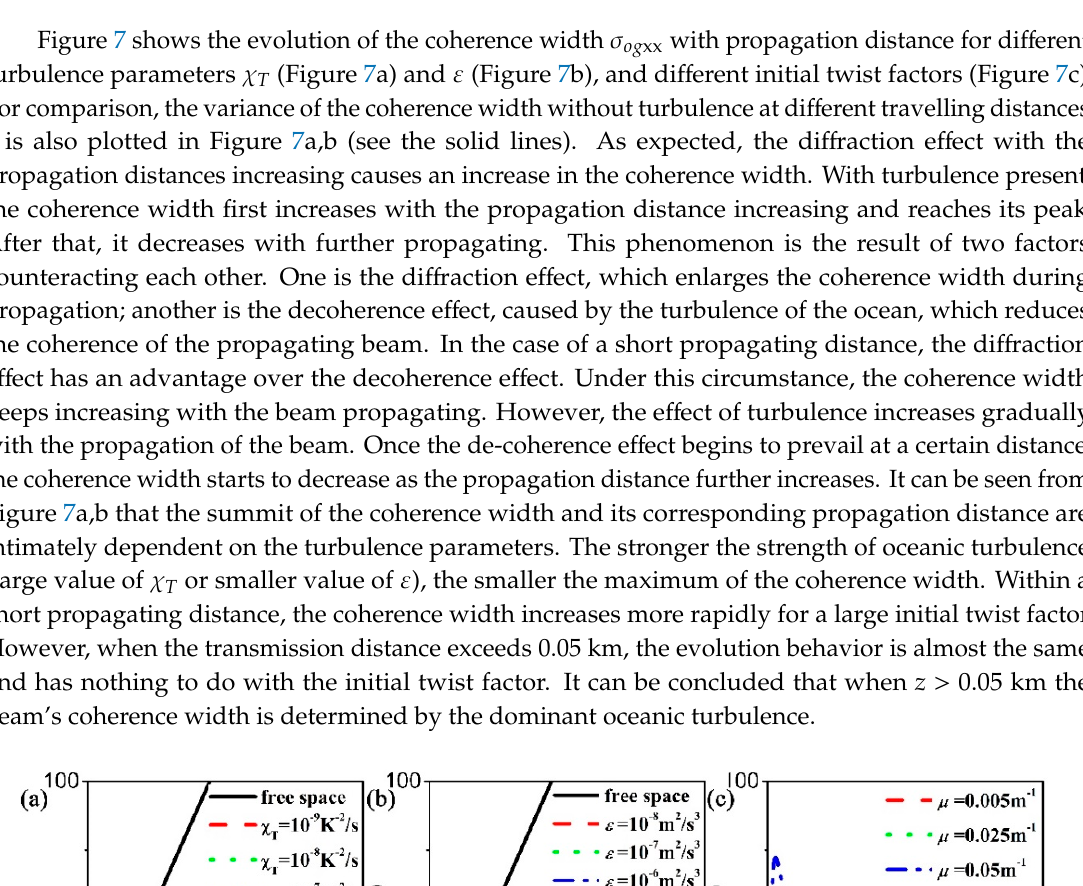
Figure 7. Evolution of the transverse coherence width σ og xx of a TAGSM beam via the propagation distances z in free space and oceanic turbulence ( a ) for di ff erent values of χ T ; ( b ) for di ff erent values of ε ; ( c ) for di ff erent values of the initial twist factors.